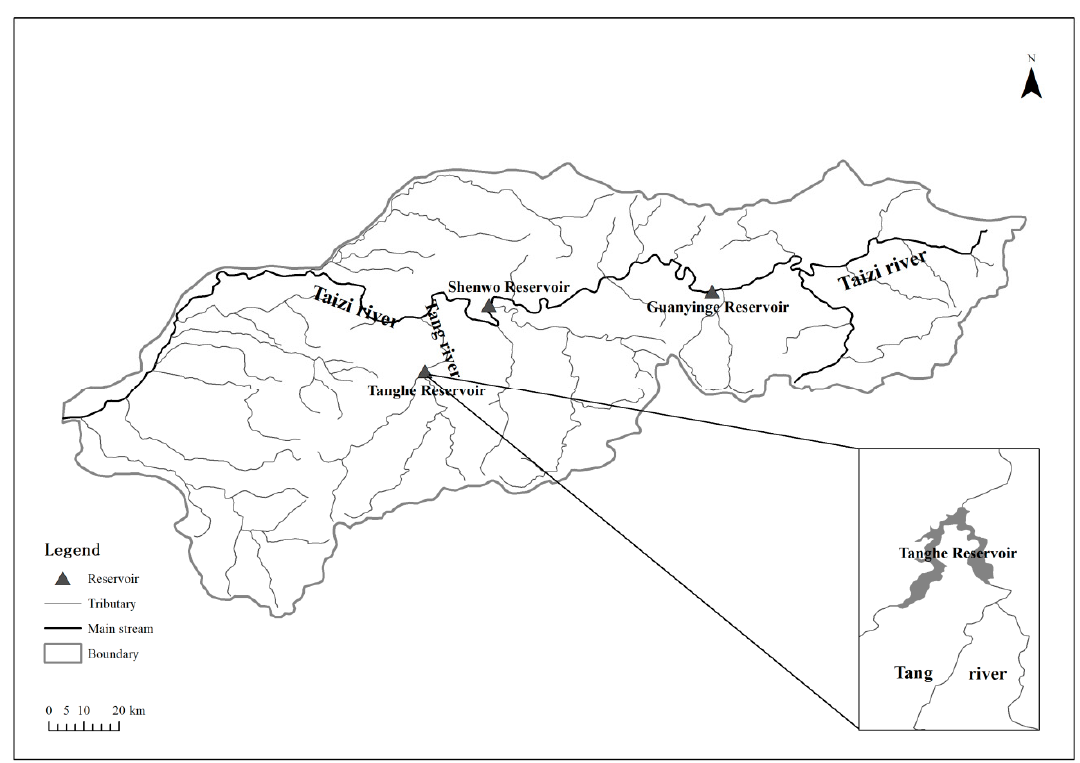
Figure 2. Location of the Tanghe Reservoir in the Taizi River basin.